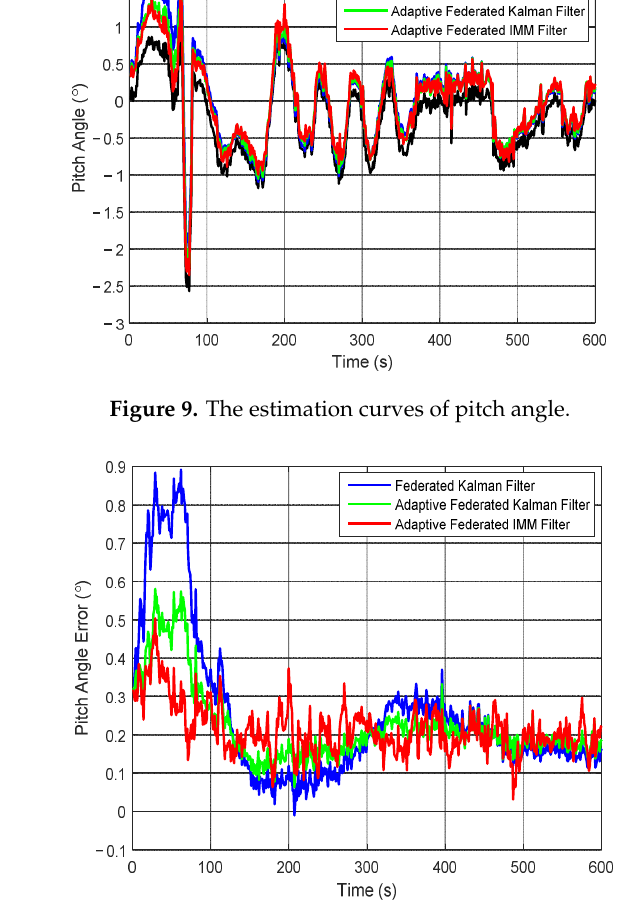
Figure 10. The estimation curves of pitch angle error.